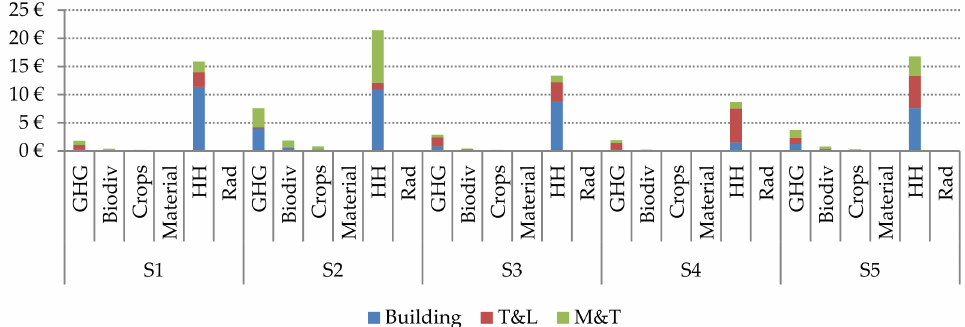
Figure 3. External costs (EC) results whole school (S1, S2, S3, S4, and S5) per student classified by the receptor affected and the damage caused (GHG: greenhouse gases damage; Biodiv: loss of biodiversity; crops: yields affection and deposition over crops; material: materials corrosion and degradation; HH: human health affection; Rad: radionuclides